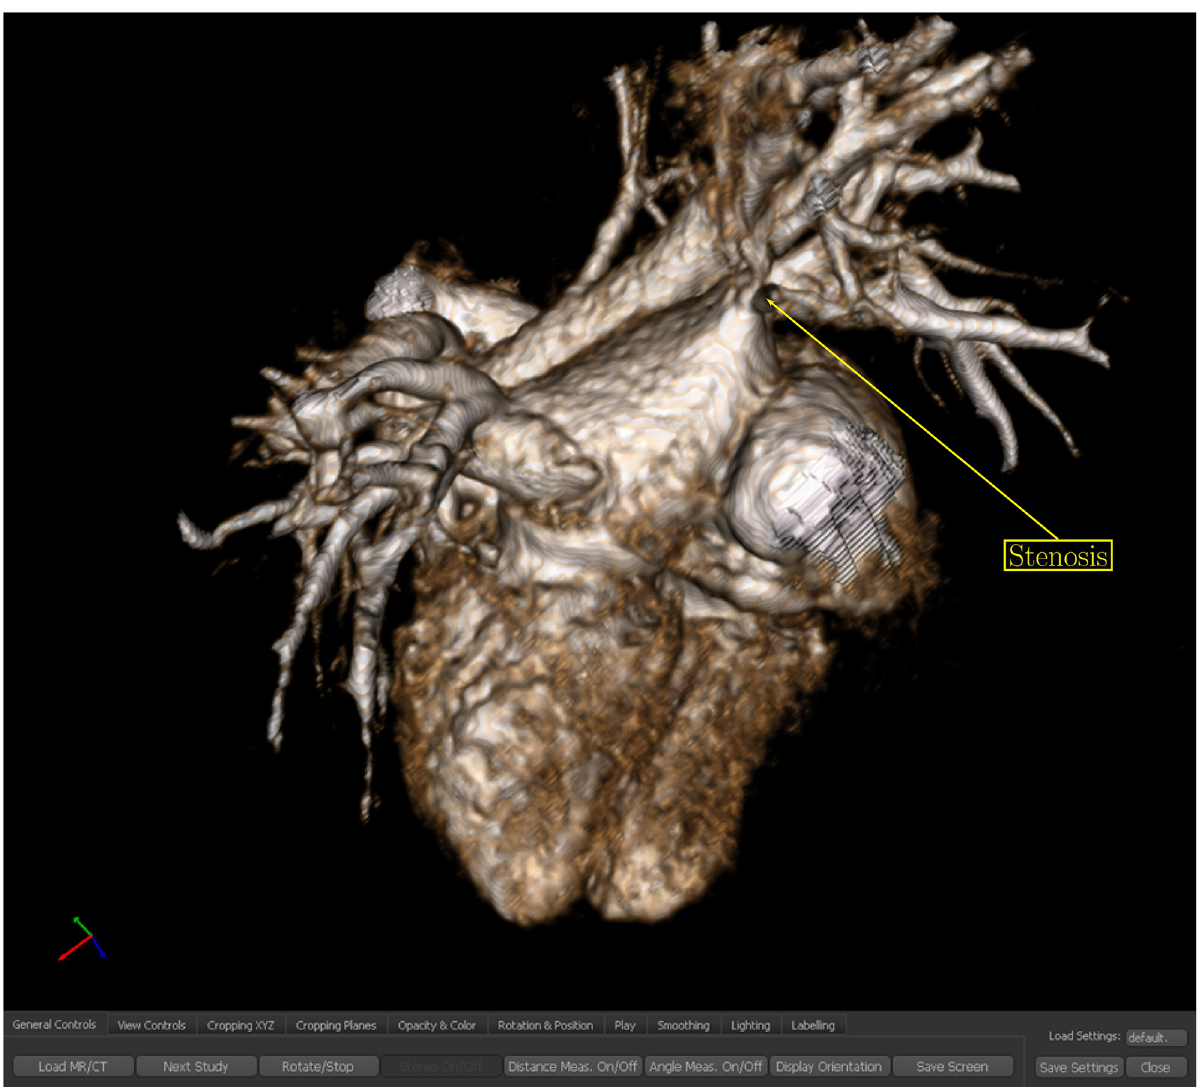
Fig 1. Volume rendered sample data set of a patient with right pulmonary vein stenosis on the viewing system. The arrow indicates the area of stenosis.